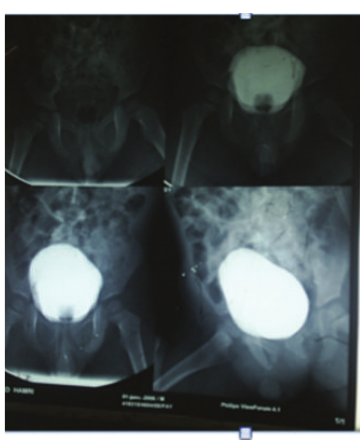
Figure 6: Case 2: male